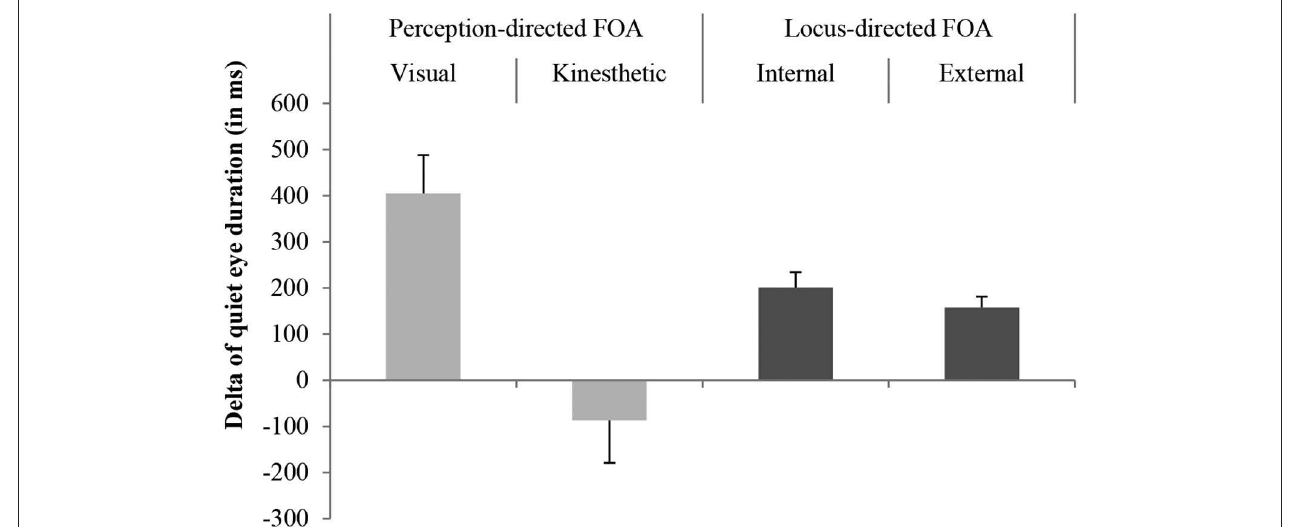
FIGURE 1 | Mean values of the variation of the quiet eye duration between pre- and posttest ( 1 ) with error bars representing the standard deviation.